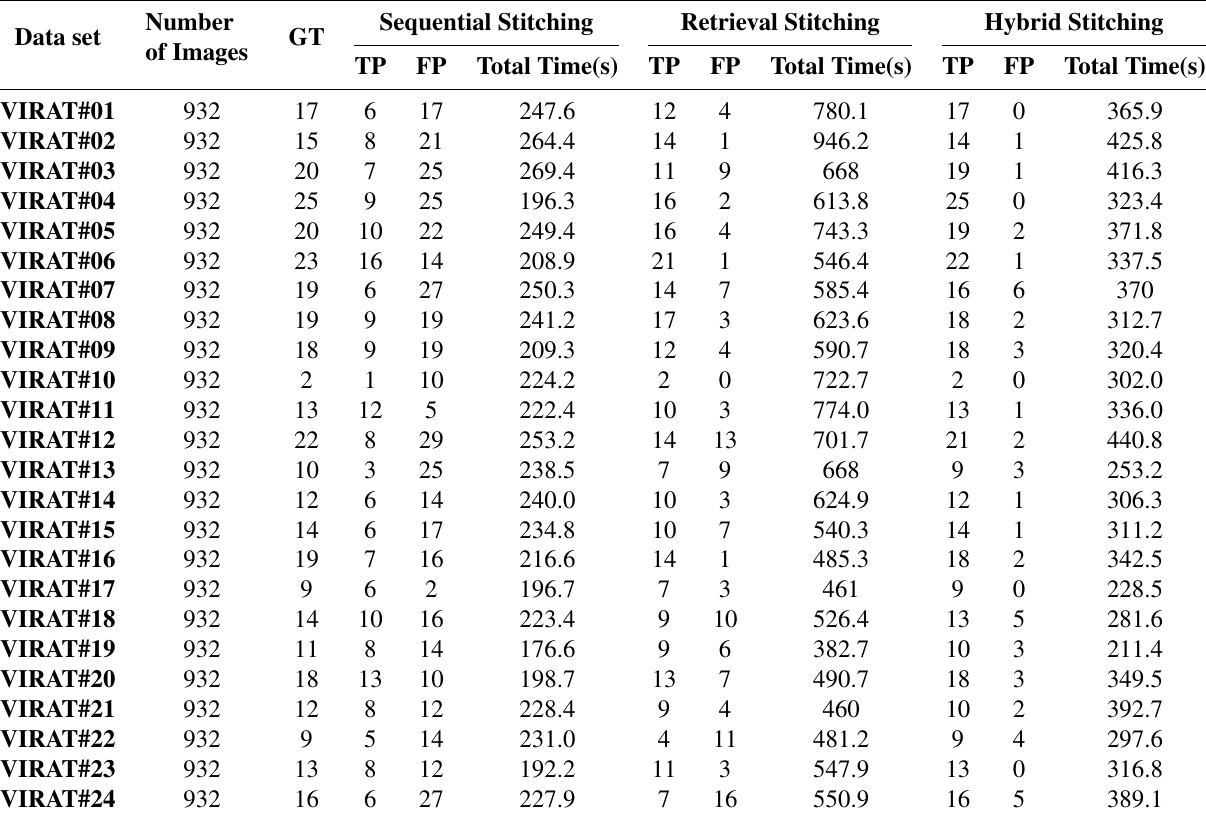
Table 1. Quantitative comparison of Sequential Stitching, Retrieval Stitching and Hybrid Stitching on 24 VIRAR